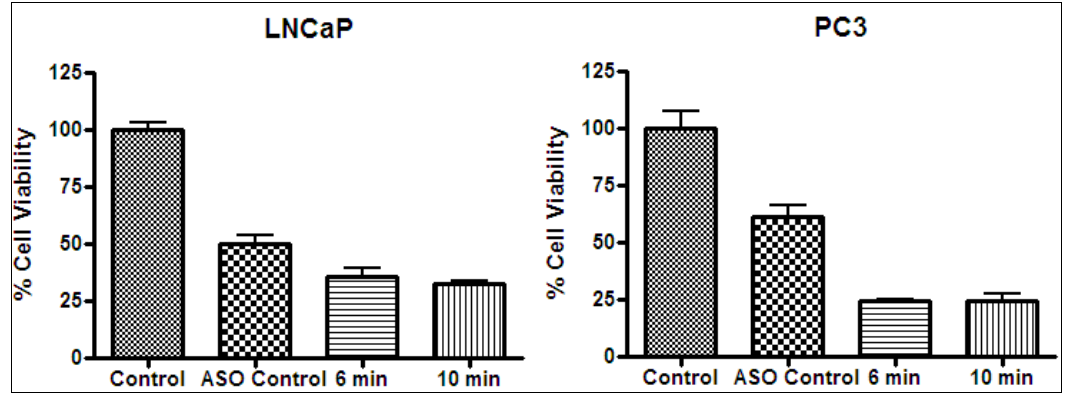
Figure 12. Representative photothermal experiment on LNCaP ( left ) and PC3 ( right ) treated with 100 nM ASO and 40 nm gold nanoshells. Irradiated with a 4 W laser with a 42 ° C background temperature.